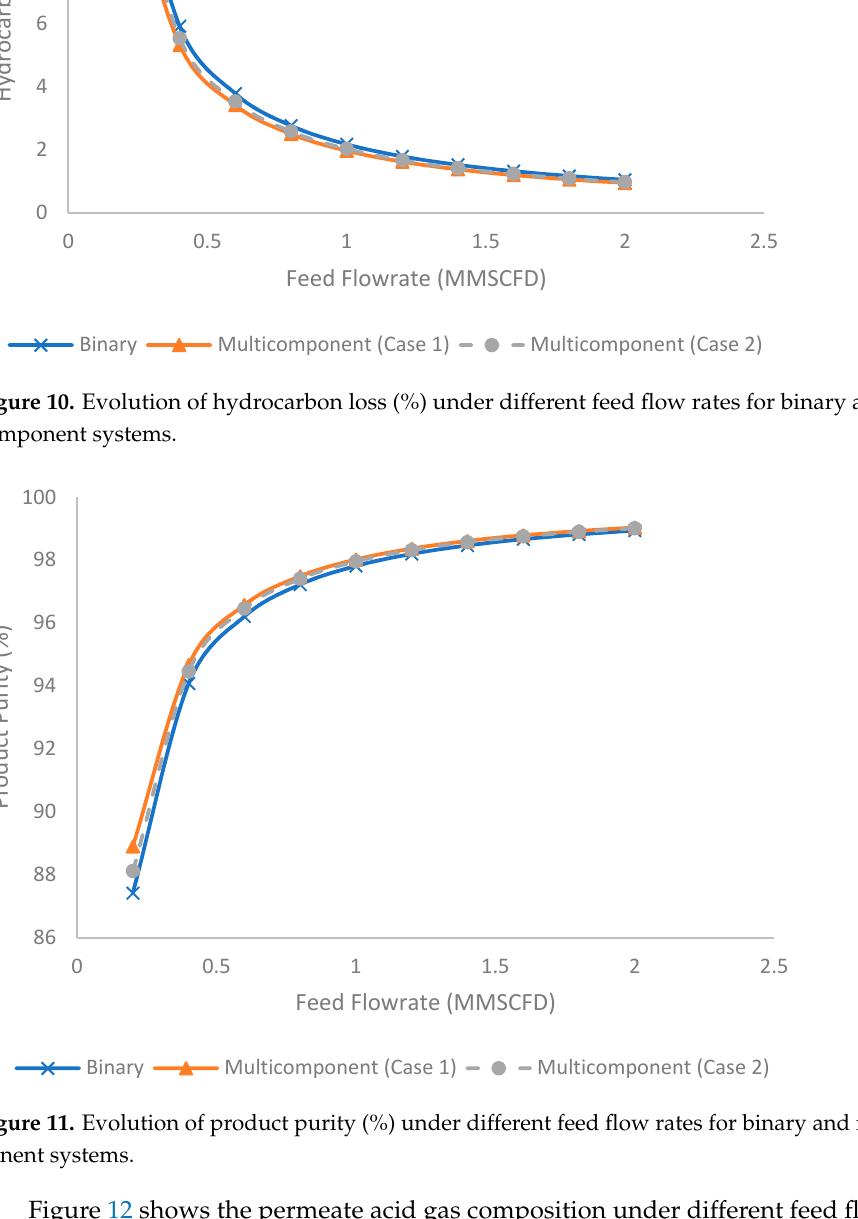
Figure 12. Evolution of permeate acid gas composition under different feed flow rates for binary and multicomponent systems.